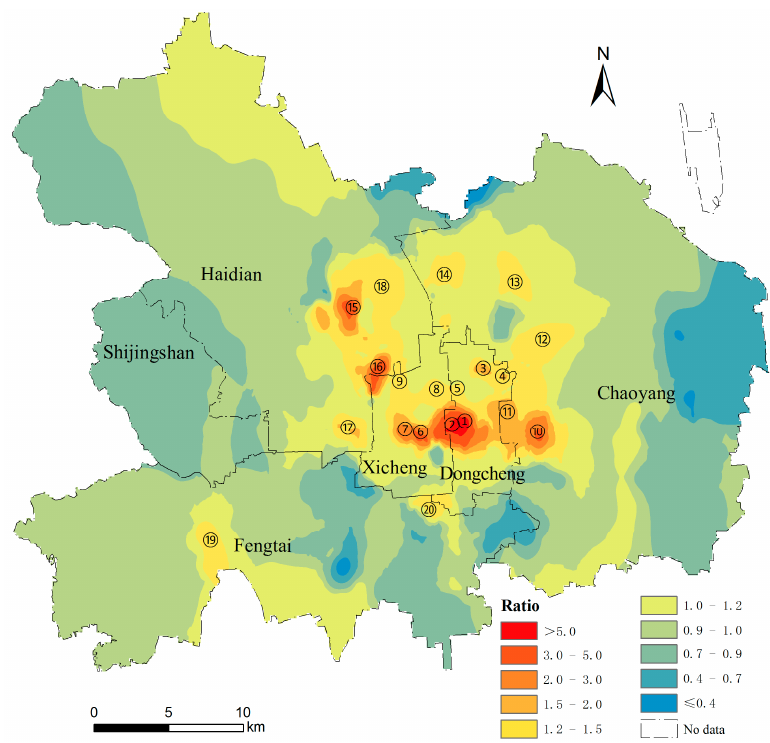
Figure 3. Spatial distribution of population ratio of day to night in the different districts of Beijing; see Table 3 for names of locations. The actual analysis units are communities; however, for a better representation, the distribution is smoothed by inverse distance-weighted interpolation. Table 3. High value areas of population ratio of day to night.